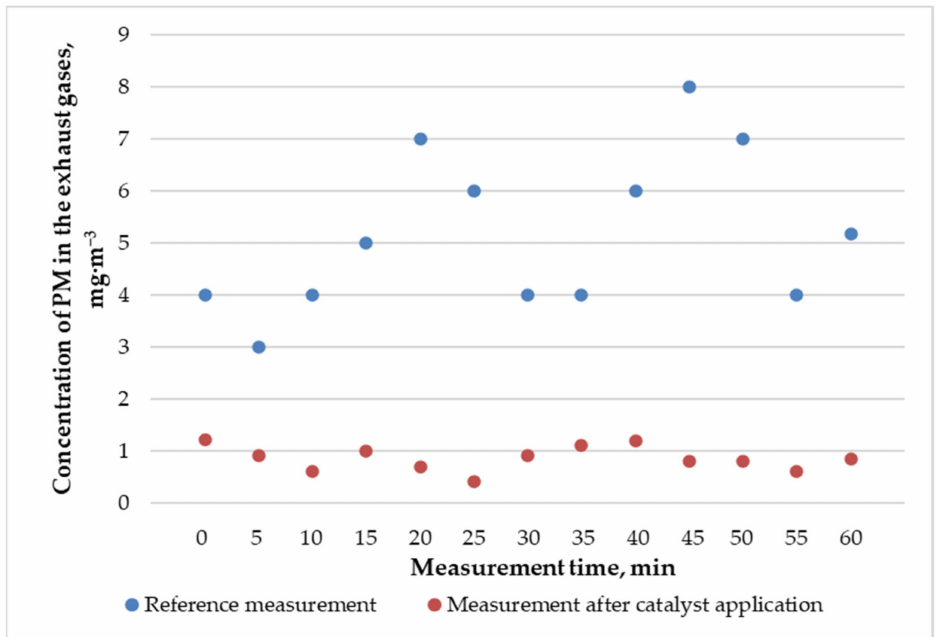
Figure 5. Comparison of PM concentration in exhaust gases without and with the use of a catalyst. During the regular operation of the cogeneration system, the PM concentration in platinum particles reduced PM emissions to an average value of 0.85 mg · m − 3 . Based